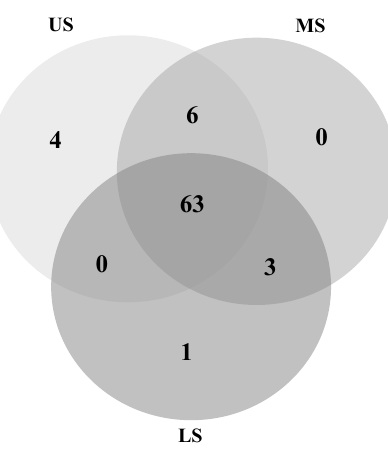
Figure 7. Venn diagram of AMF OTUs for different slope positions. US: upper slope position; MS: middle slope position; LS: lower slope position.